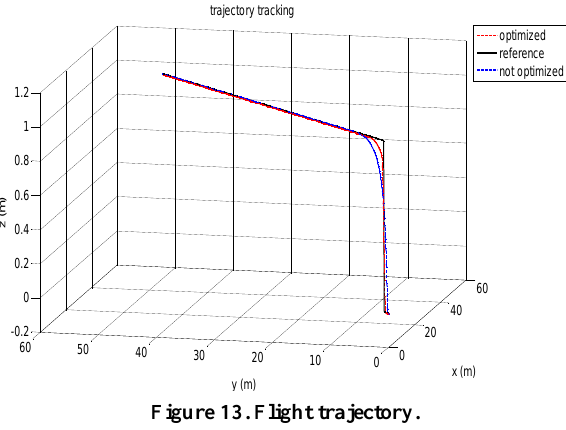
Figure 13. Flight